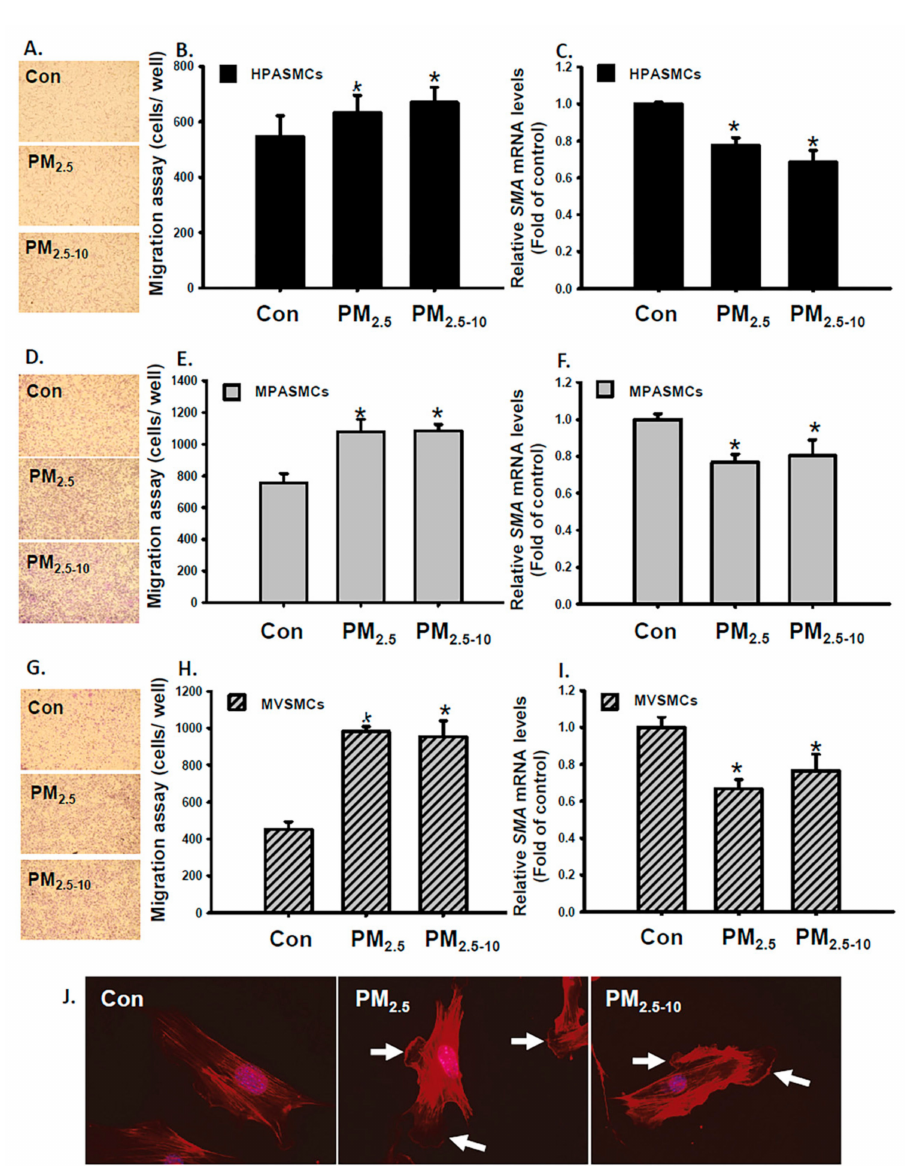
Figure 2. PM 2.5 and PM 2.5-10 induced cell migration in HPASMCs, MPASMCs, and MVSMCs. HPASMCs were treated with d 2 H 2 O or 25 µ g/mL PM 2.5 or PM 2.5-10 for 48 h. Migration abilities of HPASMCs, MPASMCs, and MVSMCs were measured, quantified and shown as ( A , B , D , E , G , H ). The relative levels of SMA mRNA for HPASMCs, MPASMCs, and MVSMCs were determined using a real-time PCR assay, and shown as ( C , F , I ). ( J ) MVSMCs were stained with Alexa Fluor 546-Phalloidin.(red) to identify lamellipodia (white arrows). The results are presented as the mean ± SD for three or four independent experiments. * p < 0.05, compared with d 2 H 2 O-treated cells. Con: d 2 H 2 O treatment as